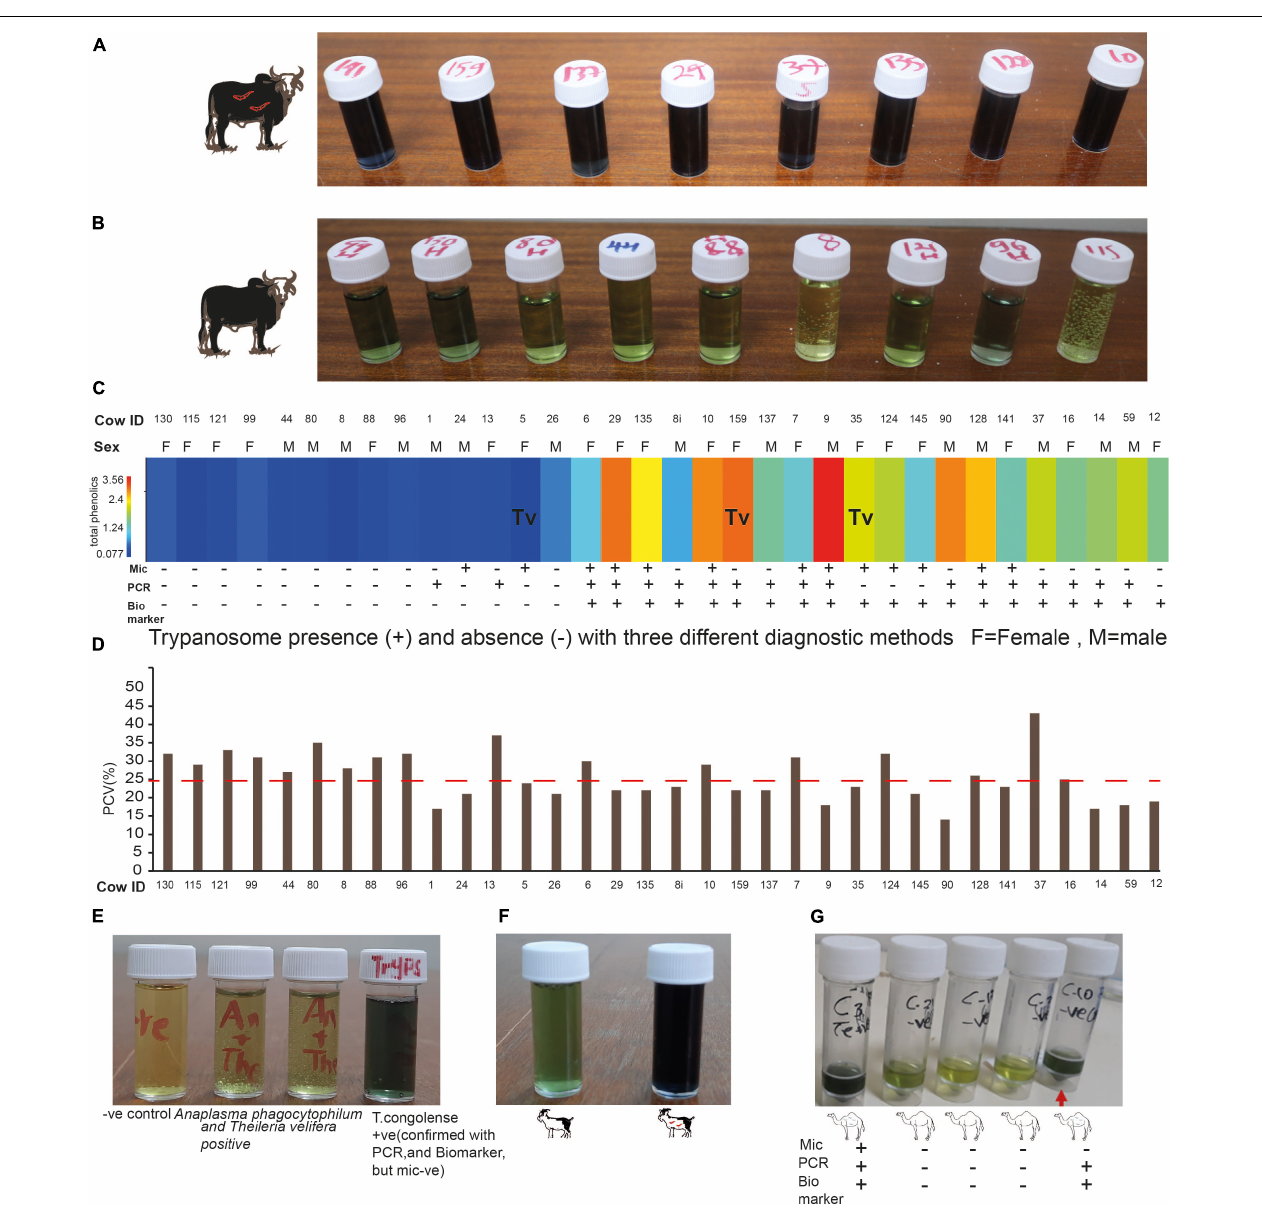
FIGURE 10 | Field validation of the biomarker-based diagnostic. (A) Representative cow urine samples from trypanosome positive cows after treatment with diagnostic reagent (see the dark blue color). (B) Representative cow urine samples from trypanosome negative cow samples (observe the green color). (C) Heat map of the total phenolic contents (unnormalized) from independent field samples both infected and uninfected cows, n = 34. (mic, microscopy; PCR, biomarker). Tv, T. vivax and the rest infected with T. congolense . (D) PCV of the 34 cows presented in (C) , the dashed line shows the threshold PCV value to be considered anemic (PCV < 25). (E) Specificity test. (F) Trypanosomosis diagnosis in goat. (G) Camel trypanosomosis (surra)